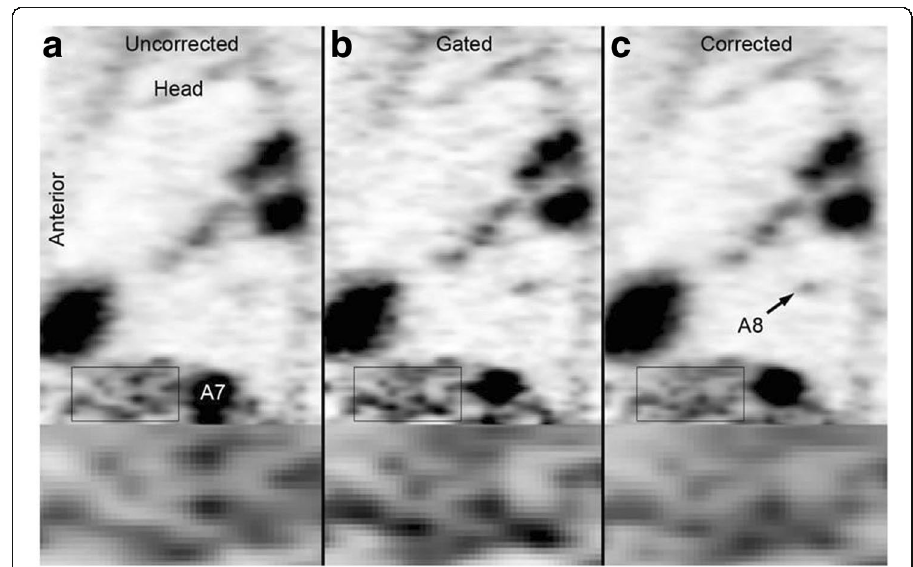
Fig. 10 Comparison of uncorrected ( a ), gated ( b ), and corrected ( c ) sagittal PET image slice featuring lesions A7 and A8 in patient A. Multiple lesions and inflammatory areas with increased 18F-FDG uptake in lung show enhanced delineation (This research was originally published in Würslin C, Schmidt H,